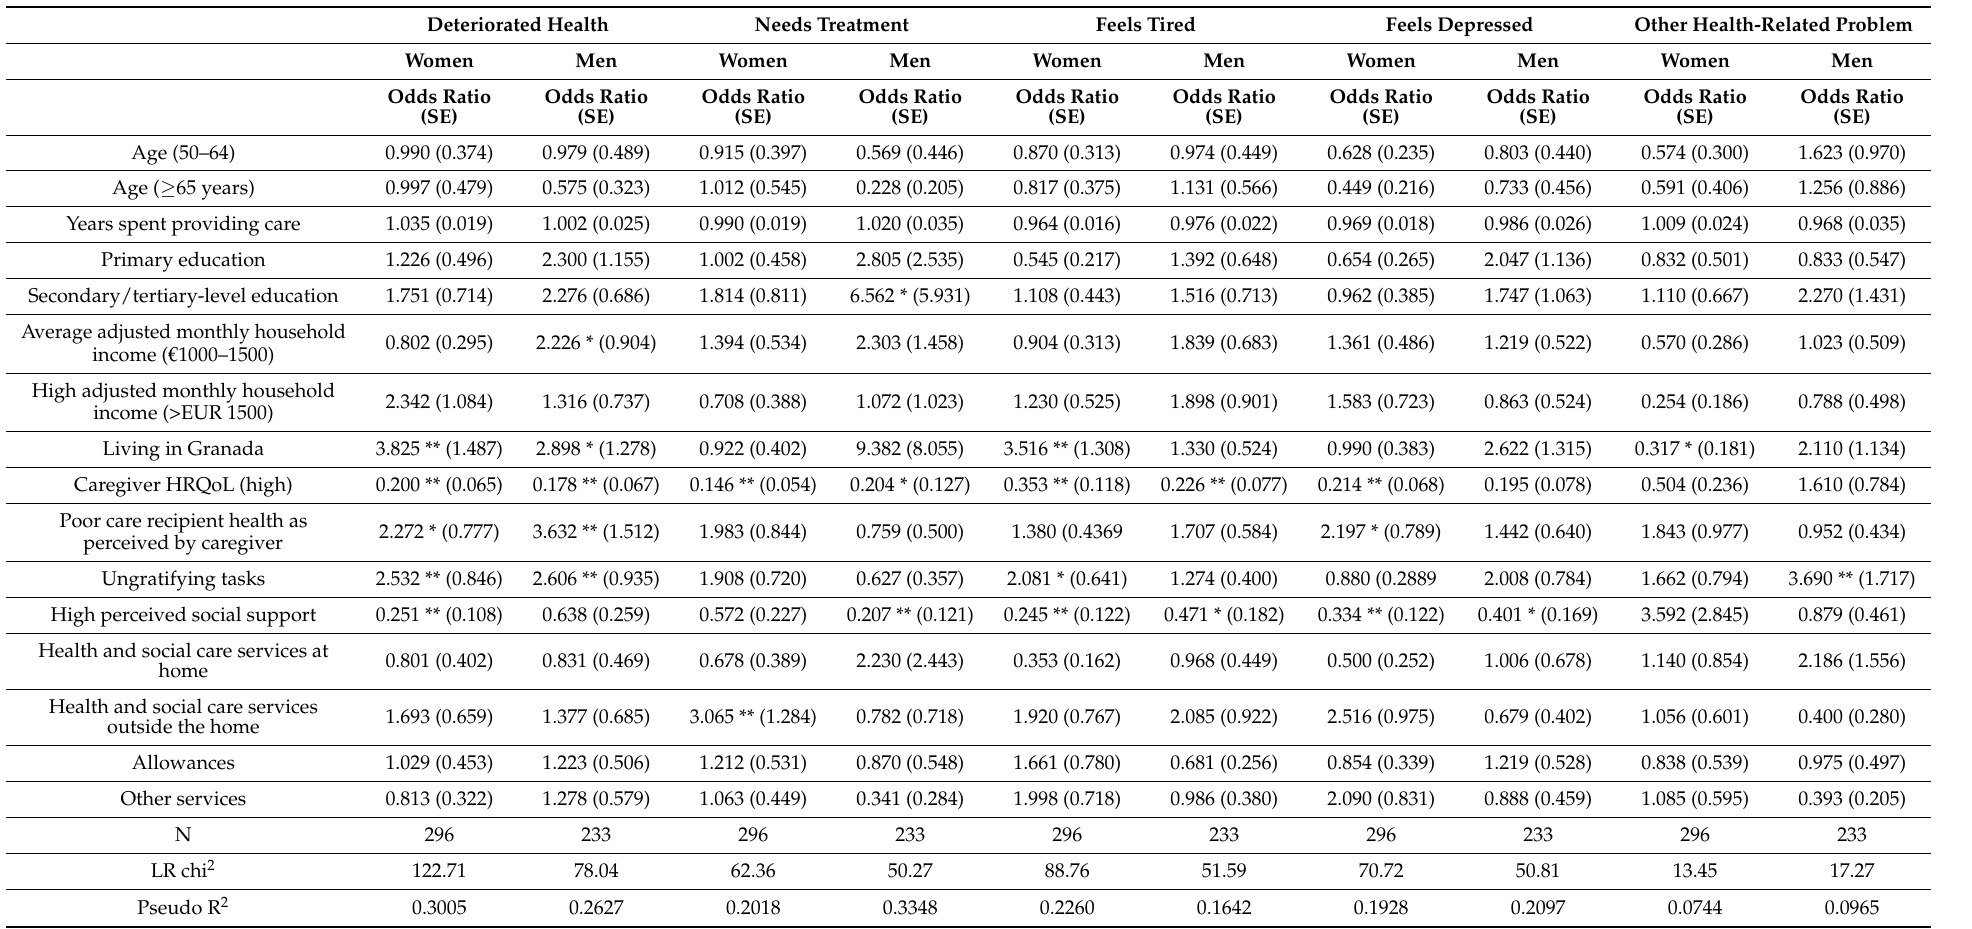
Table 4. Analysis of health problems perceived by male and female